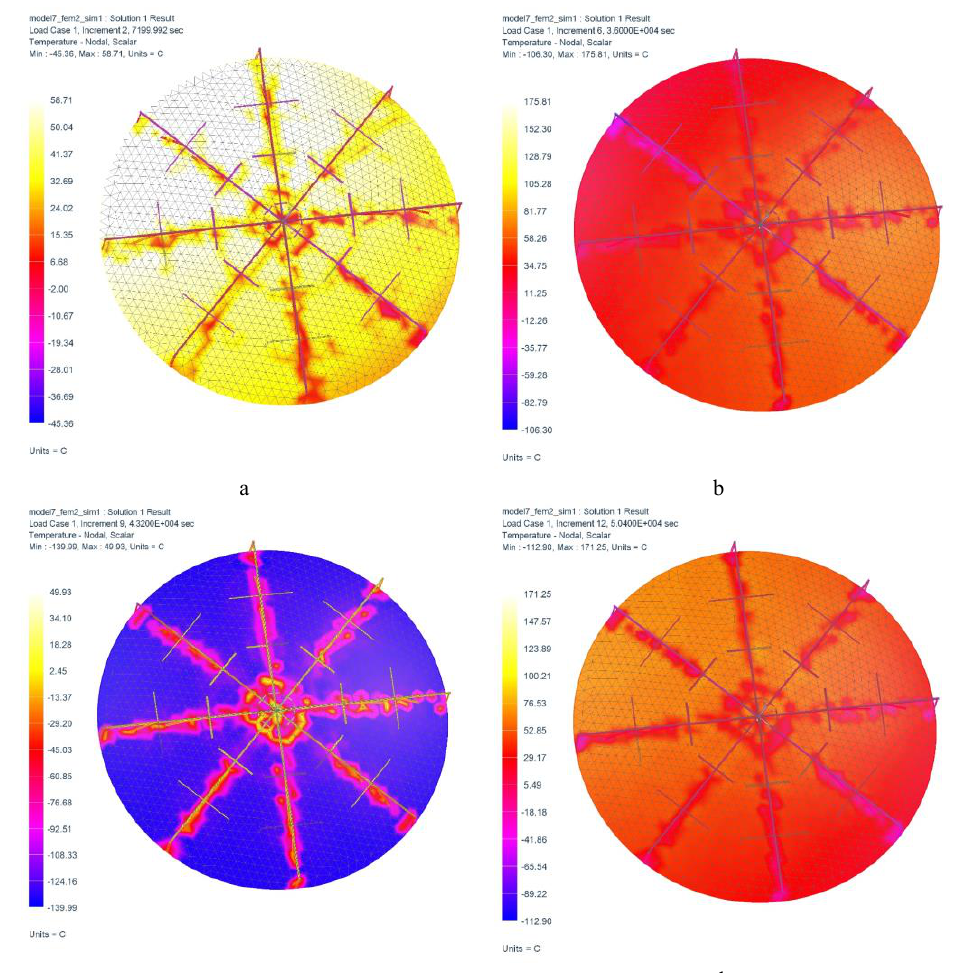
Fig. 2. Temperature state of the transformable antenna reflector on the orbit, º C: a – illumination by the Sun from the rear side; b – side illumination by the Sun; c – entering the Earth shadow; d – staying in the Earth shadow.